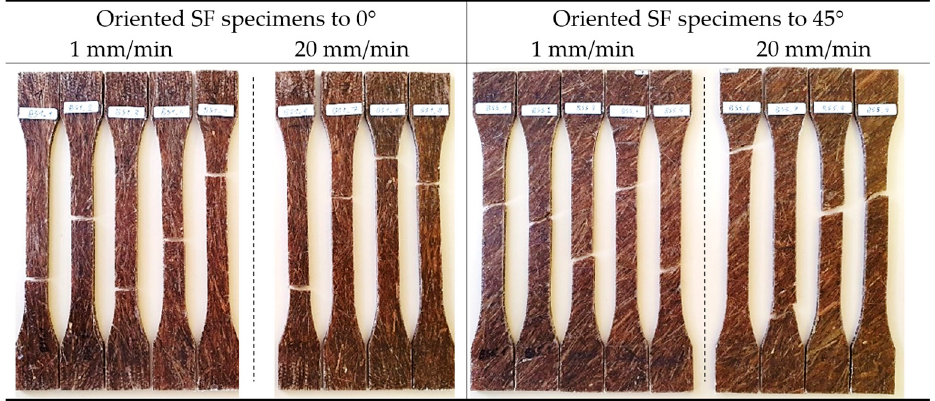
Figure 11. Tensile test on sorted fibers oriented 0° ( right ) and 45° ( left ); for a traverse speed of 1 mm/min and 20 mm/min.